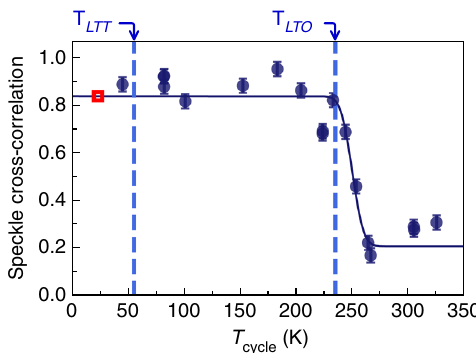
Fig. 4 CDW memory. Normalized speckle cross-correlation coef fi cient, ξ , of data before and after temperature cycling to different values of T cycle . Images of 200 × 200 detector pixels were used for this calculation. An error function fi t gives a de-correlation onset temperature of 240(3) K, which coincides with the LTO structural phase transition. The red box indicates 24 K the temperature where all the speckle images were sampled for this fi gure. Error bars are estimated by taking the standard deviation of repeated, nominally equivalent,